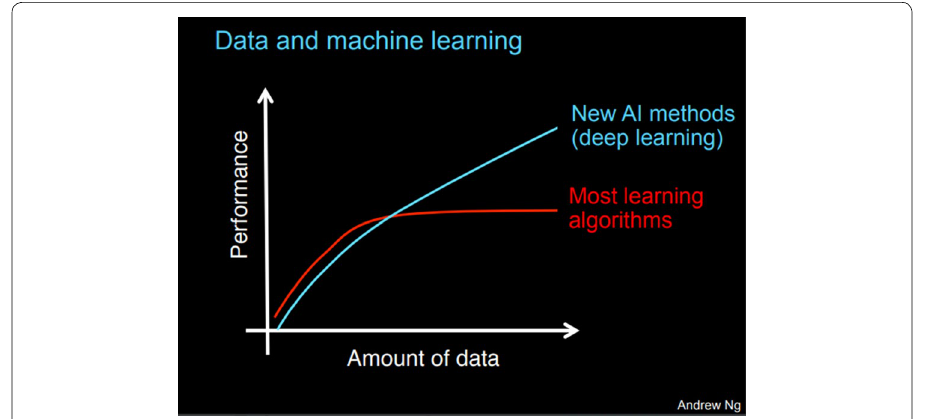
Fig. 9 Big data with deep learning performance optimization [36, 37]. Shows performance optimization when using bigger amount of data